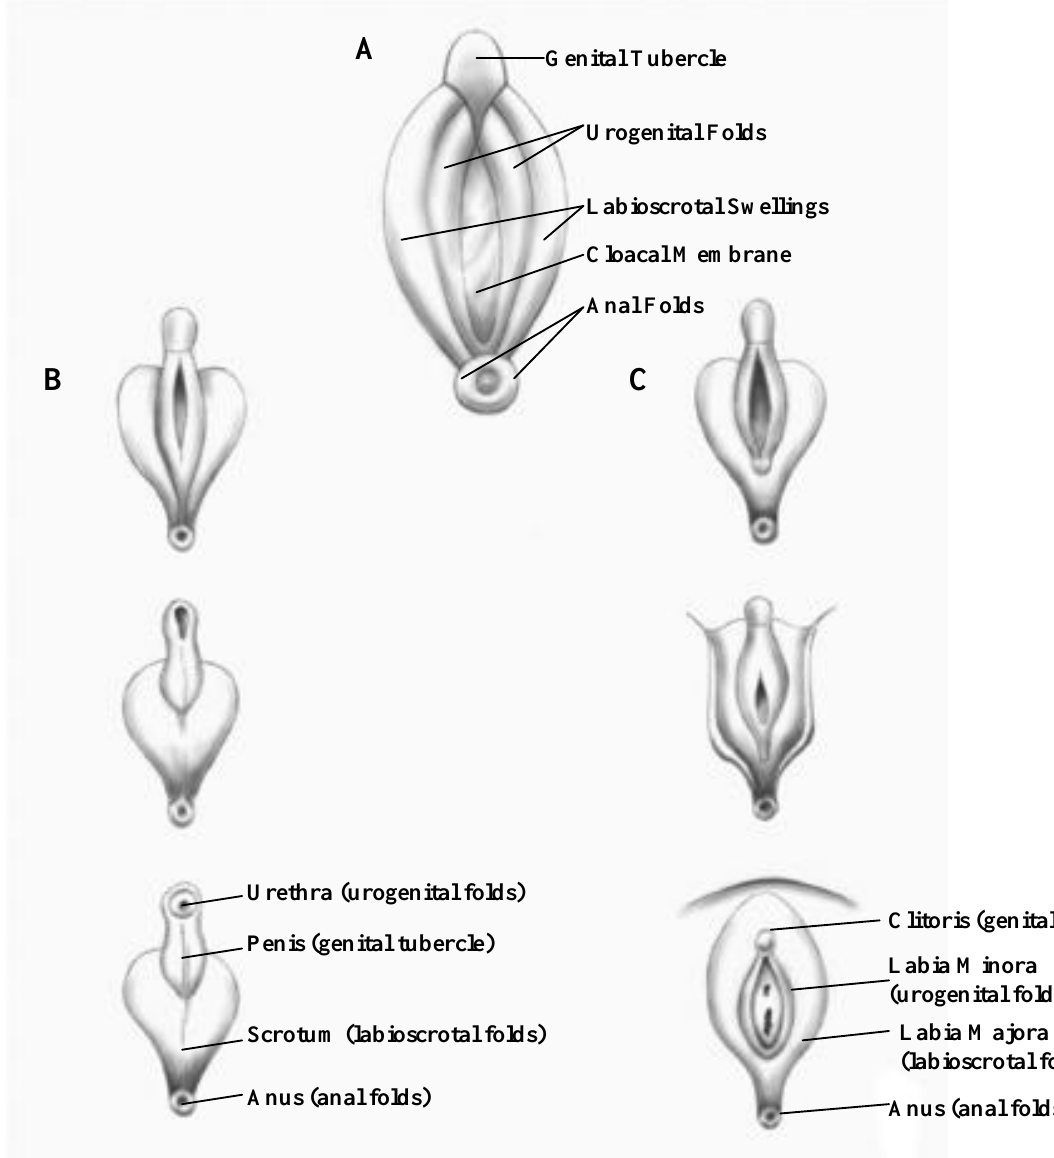
FIGURE 1 . Human urogenital embryology. (A) Sex undifferentiated precursors prior to 7 weeks gestational age. (B) Male development in gestational weeks 7–17 from precursors shown in (A). (C) Female development in weeks 7–17 from precursors shown in (A).